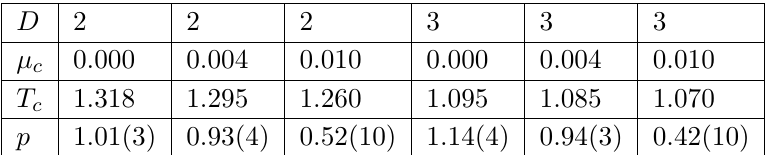
Table 1 . The power p in the (cid:12)tting of the susceptibility (cid:31) = (cid:13)N 2 p + c